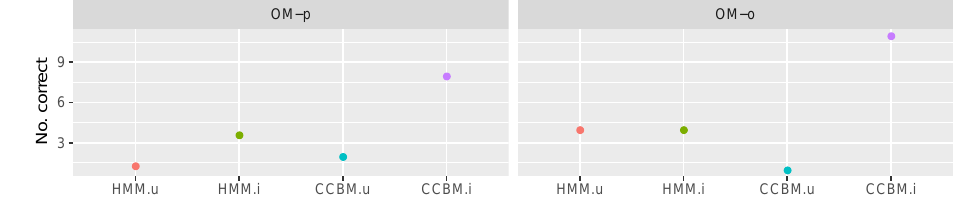
Figure 14. Single-goal recognition results, meal goals. OM-o refers to the optimistic observation model, OM-p to the pessimistic observation model, HMM.u is the HMM with uninformed a priori goal probabilities, HMM.i is the HMM with informed a priori goal probabilities, CCBM.u is the CCBM with uninformed a priori goal probabilities, and CCBM.i is the CCBM with informed a priori goal